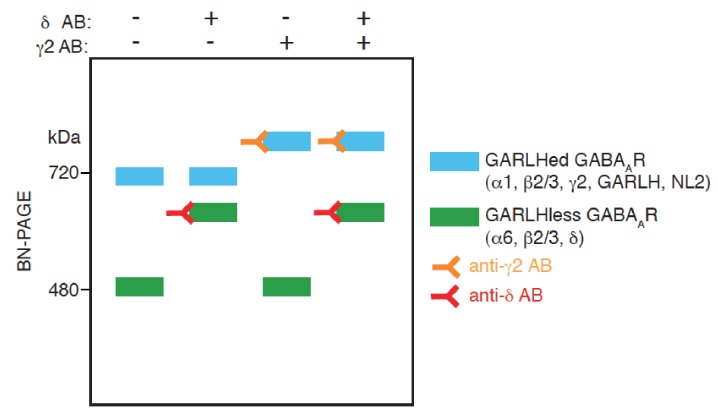
A schematic diagram of an antibody shift assay for distinct GABAAR complexes on BN-PAGE.GABAARs comprised of α6, β2/3 and δ form a complex at 480 kDa, and the addition of an anti-δ antibody to the complex shifts its mobility on BN-PAGE. On the other hand, GABAARs comprised of α1, β2/3 and γ2 form complexes with GARLH and NL2 at 720 kDa, and the addition of an anti-γ2 antibody to the complex shifts its mobility. When both anti δ and γ2 antibodies are added, mobility of both the complexes at 480 and 720 kDa are shifted.